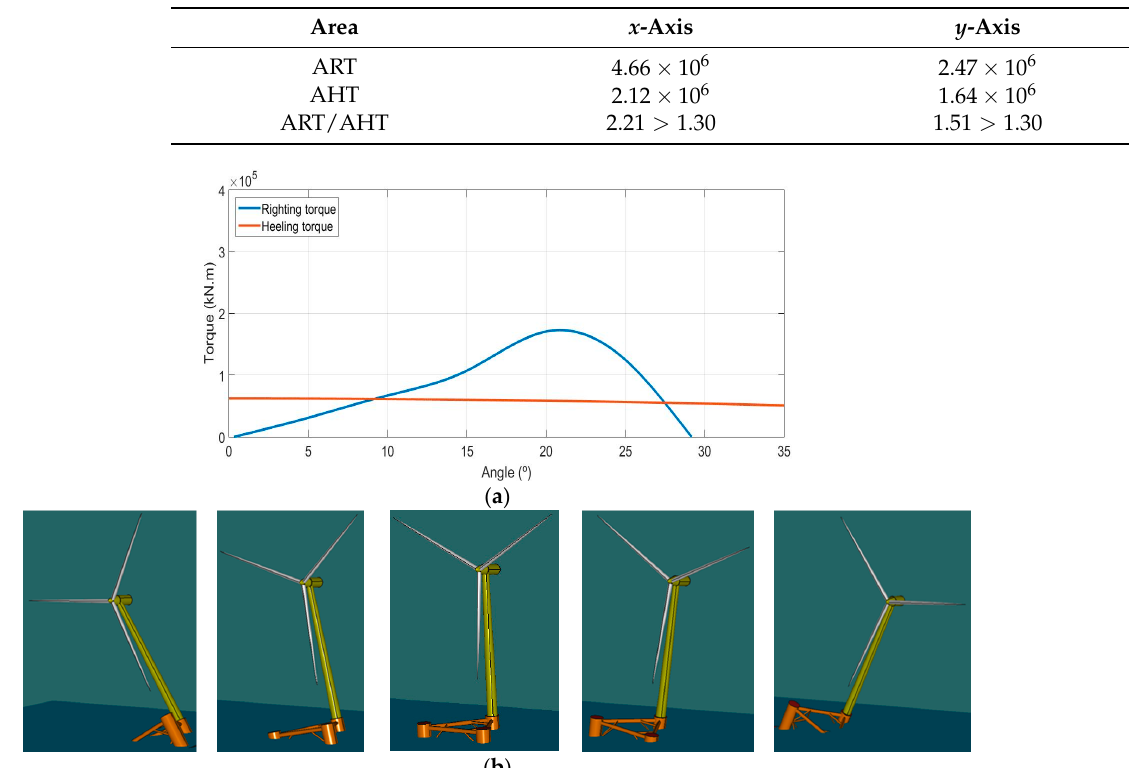
Figure 3. Curve of static stability of the device with respect to the y -axis. ( a ) Curve of static stability for y -axis and ( b ) rotating platform around the y -axis (stable range).